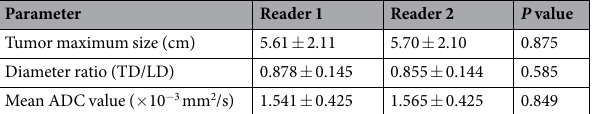
Table 2. Quantitative characteristics of retroperitoneal extra-adrenal paragangliomas. Note: Values are mean values ± standard deviations. P values were calculated using t tests. Diameter ratio = Mean TD (transverse diameter)/Mean LD (longitudinal diameter). ADC: Apparent Diffusion